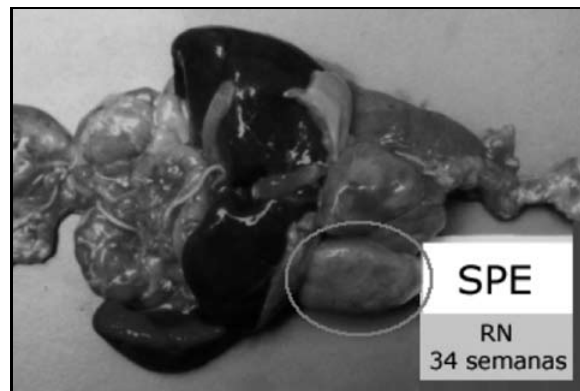
Figura 4 – Aspecto macroscópico do caso 2 Seta: seqüestro pulmonar extralobar.